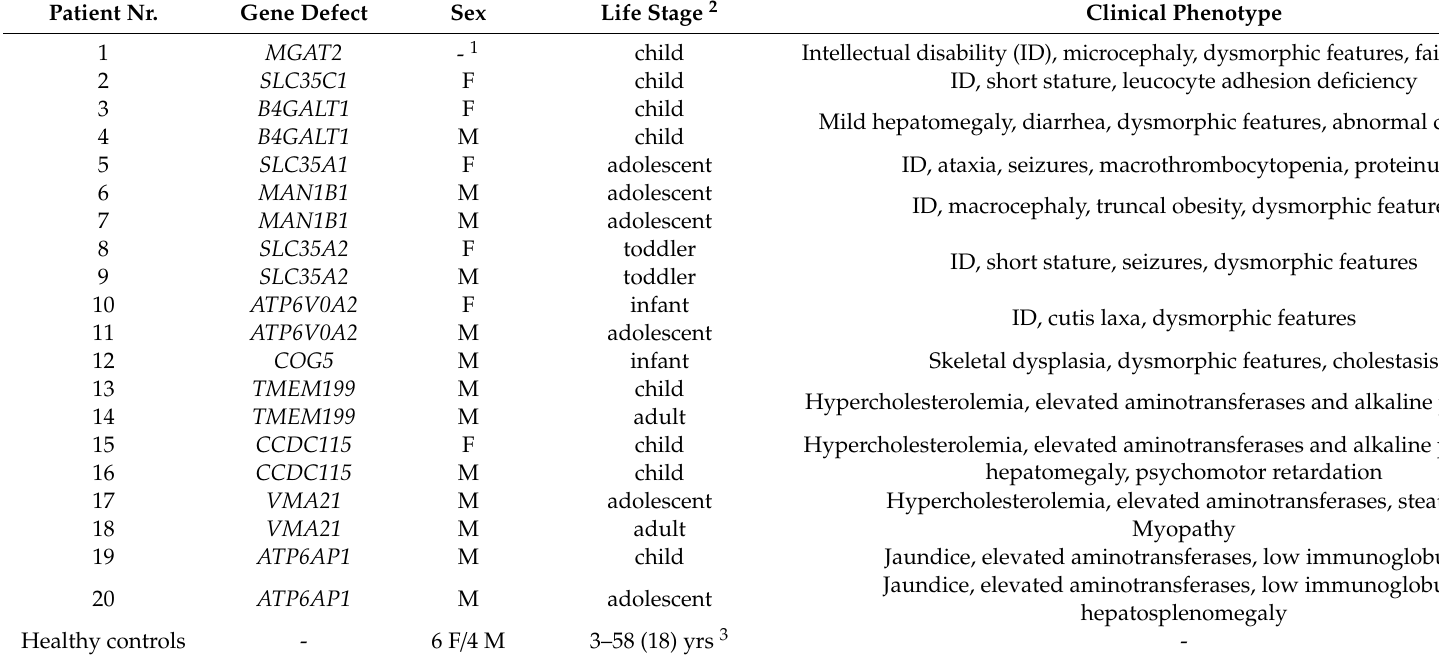
Table 1. Characteristics of patient